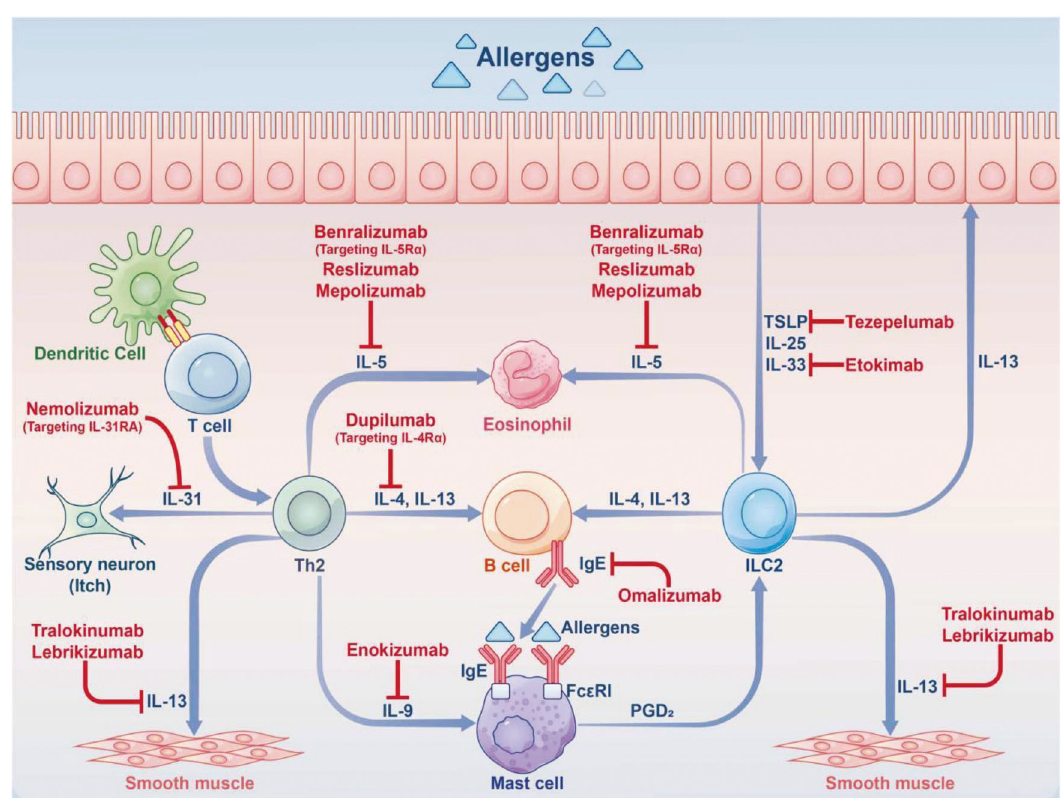
Fig. 6 Application of biologics in allergic diseases. Multiple cell interactions trigger allergic reactions. Therefore, treatment with biologics aims to target the cytokines produced by various cells, with a potential impact on the interaction between cells. Some biologics exert their effects by targeting IgE, IL-5, IL-4, IL-13, IL-31, IL-9, IL-33, and TSLP, among